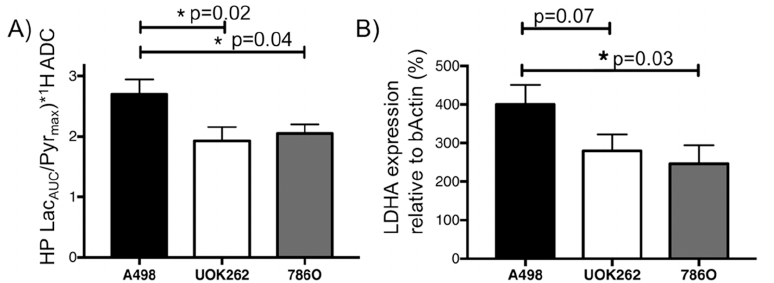
Figure 3. Dynamic HP 13 C MRI to interrogate pyruvate-to-lactate conversion in orthotopic RCC tumors. ( A ) Tumor 13 C pyruvate-to-lactate conversion, represented by Lac AUC /Pyr max , normalized by the tumor 1 H ADC to adjust for the differential cellularity of the tumors. The normalized pyruvate-to-lactate conversion was significantly higher in the A-498 tumors compared to the UOK262 tumors ( p = 0.02) and 786-O tumors ( p = 0.04). ( B ) The LDHA expression of A498 tumors was significantly higher than that of 786-O tumors ( p = 0.03). The LDHA expression of A498 was also higher than that of UOK262 tumors, with a p-value approaching significance ( p = 0.07). * denotes statistically significant change ( p <